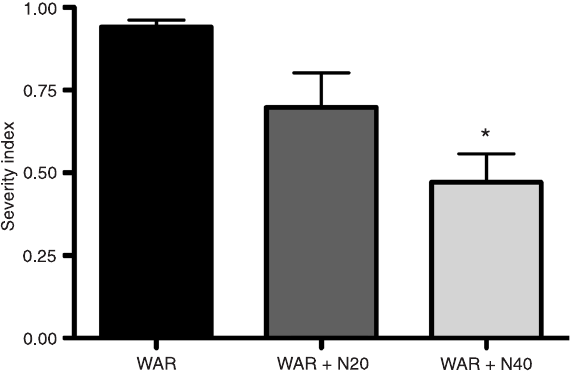
Figure 1. Severity index of seizures in Wistar audiogenic rats (WAR) treated or not with 20 or 40 mg/kg nifedipine (N20 or N40). Data are reported as means ± SEM for 6 rats per group. *P < 0.05 compared to untreated animals (WAR) (Kruskal-Wallis test followed by the Dunn post-test).